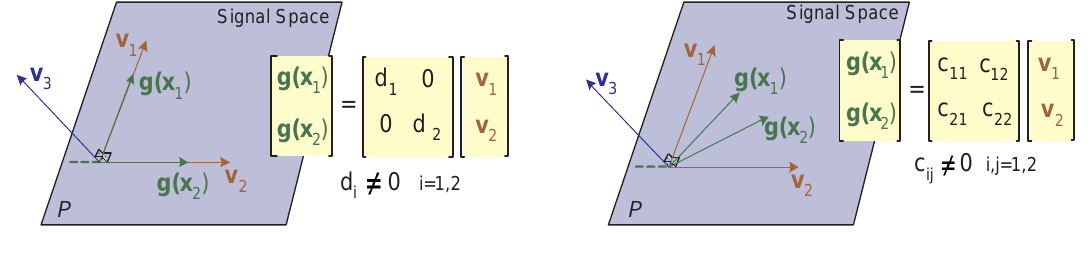
Figure 10. Illustration of well-resolved and non-well-resolved cases for a scenario having M = 2 scatterers and probed with N = 3 antennas. While the SS is formed by the plane s ( P ) formed by the first two eigenvectors ( v orthogonal to P